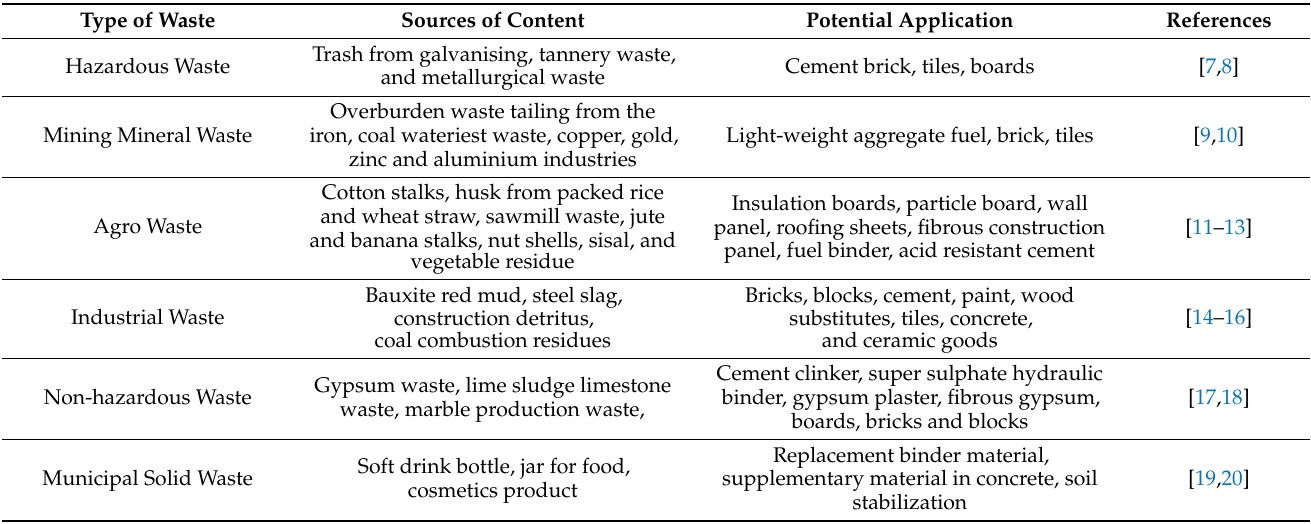
Table 2. Solid wastes and related possible uses are described in